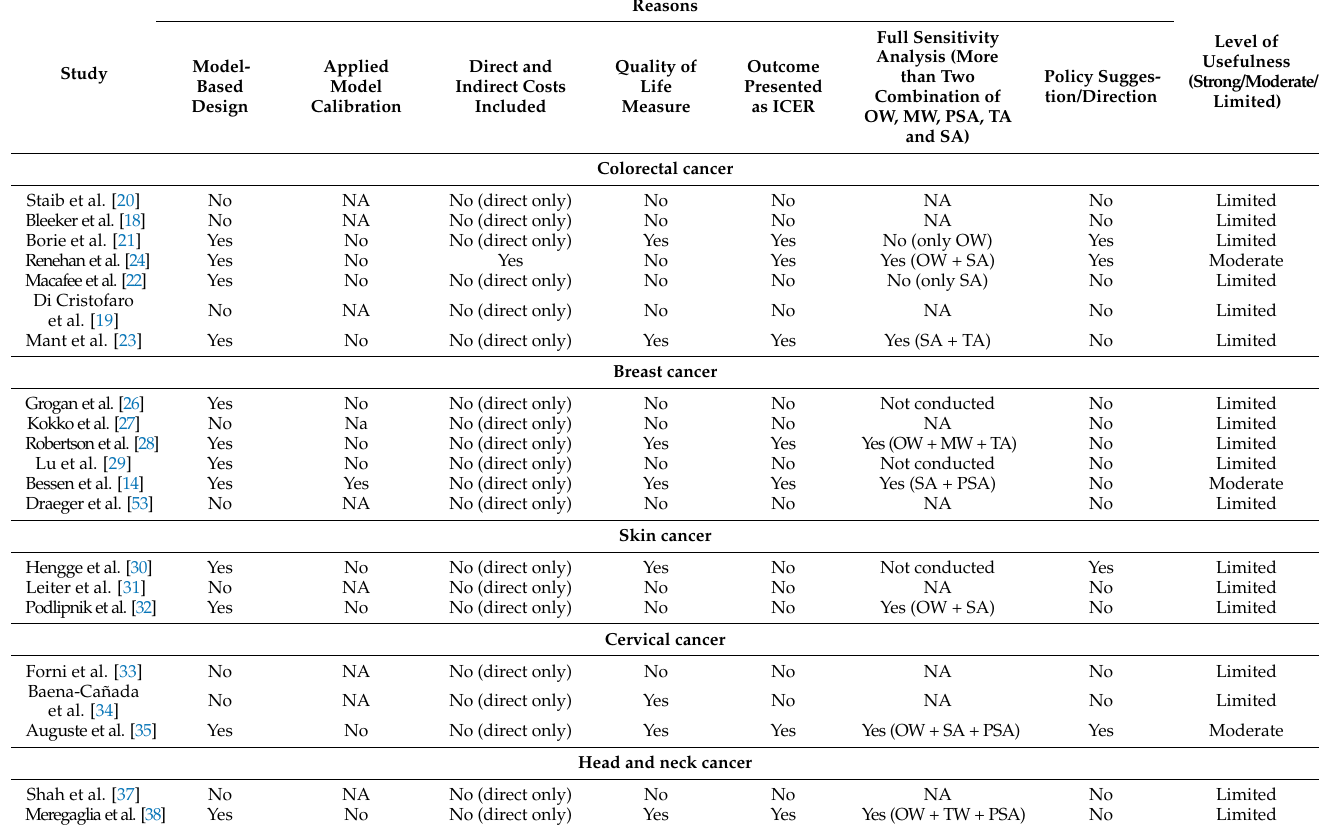
Table 2. Usefulness of reviewed studies to decision-making